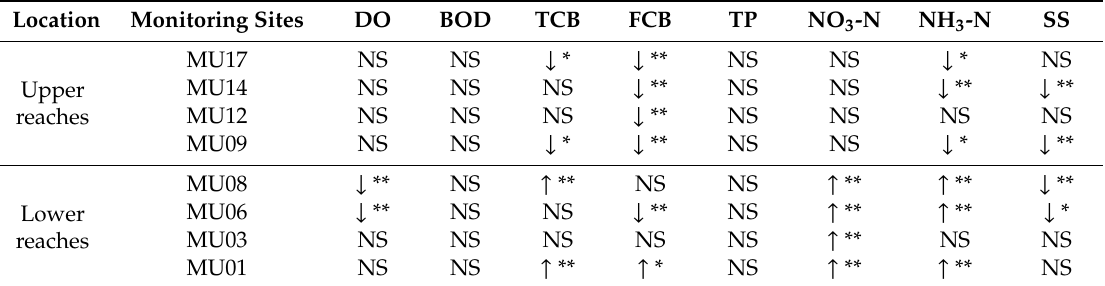
Table 1. The seasonal Kendall test of the eight parameters at eight monitoring sites during the past two decades (1997–2017).